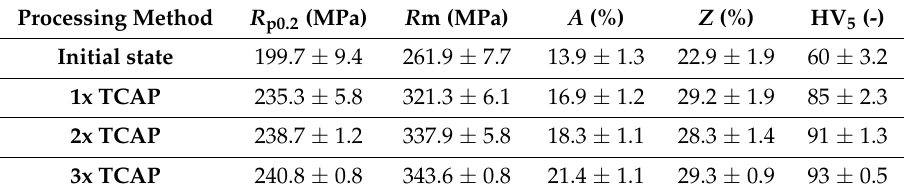
Figure 15. Engineering stress-strain curves of examined samples. Table 2. Tensile properties and hardness with the standard deviation of the AZ61 magnesium alloy.